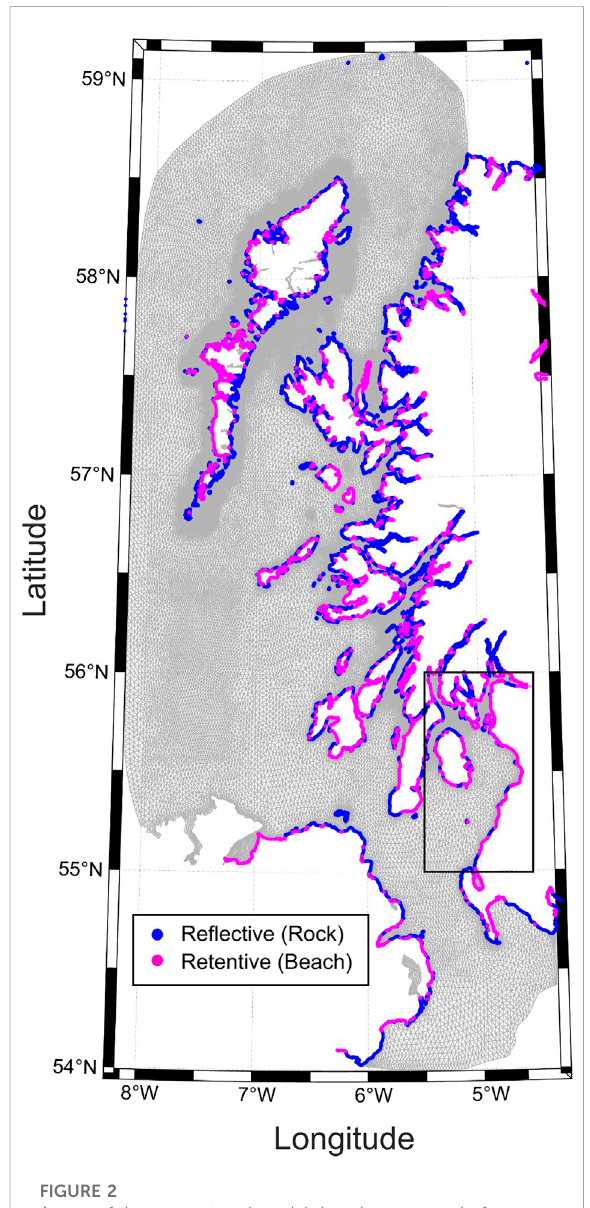
FIGURE 2 A map of the unstructured model domain composed of triangular elements and coastal classi fi cation of the model coastline. Re fl ective segments (rock) are highlighted in blue, and retentive segments (beach) are highlighted in pink. The source area is shown by the black box, with the particles starting locations chosen randomly in space within this